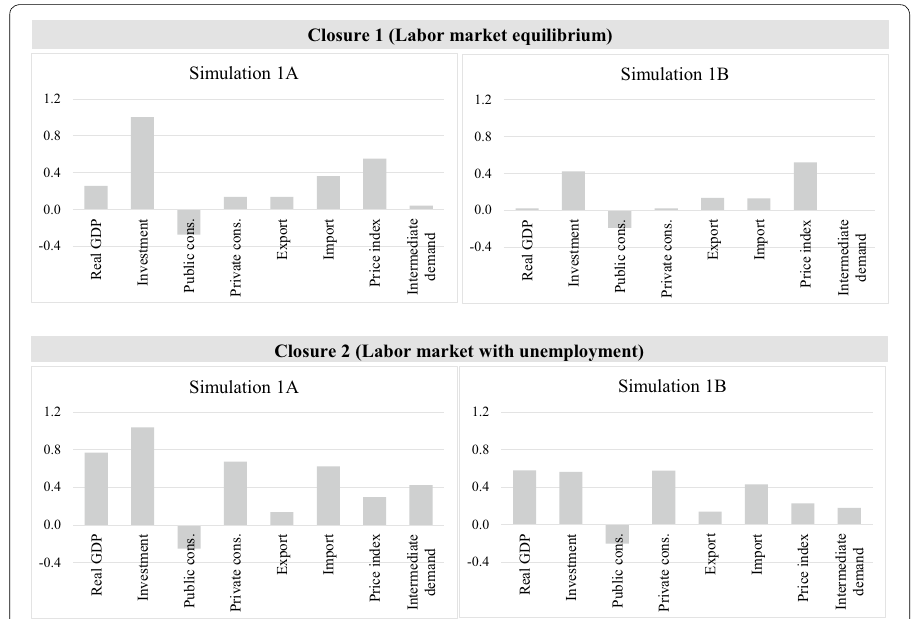
Fig. 4 Simulation results of export demand shocks (% change from base data). Source : Author’s